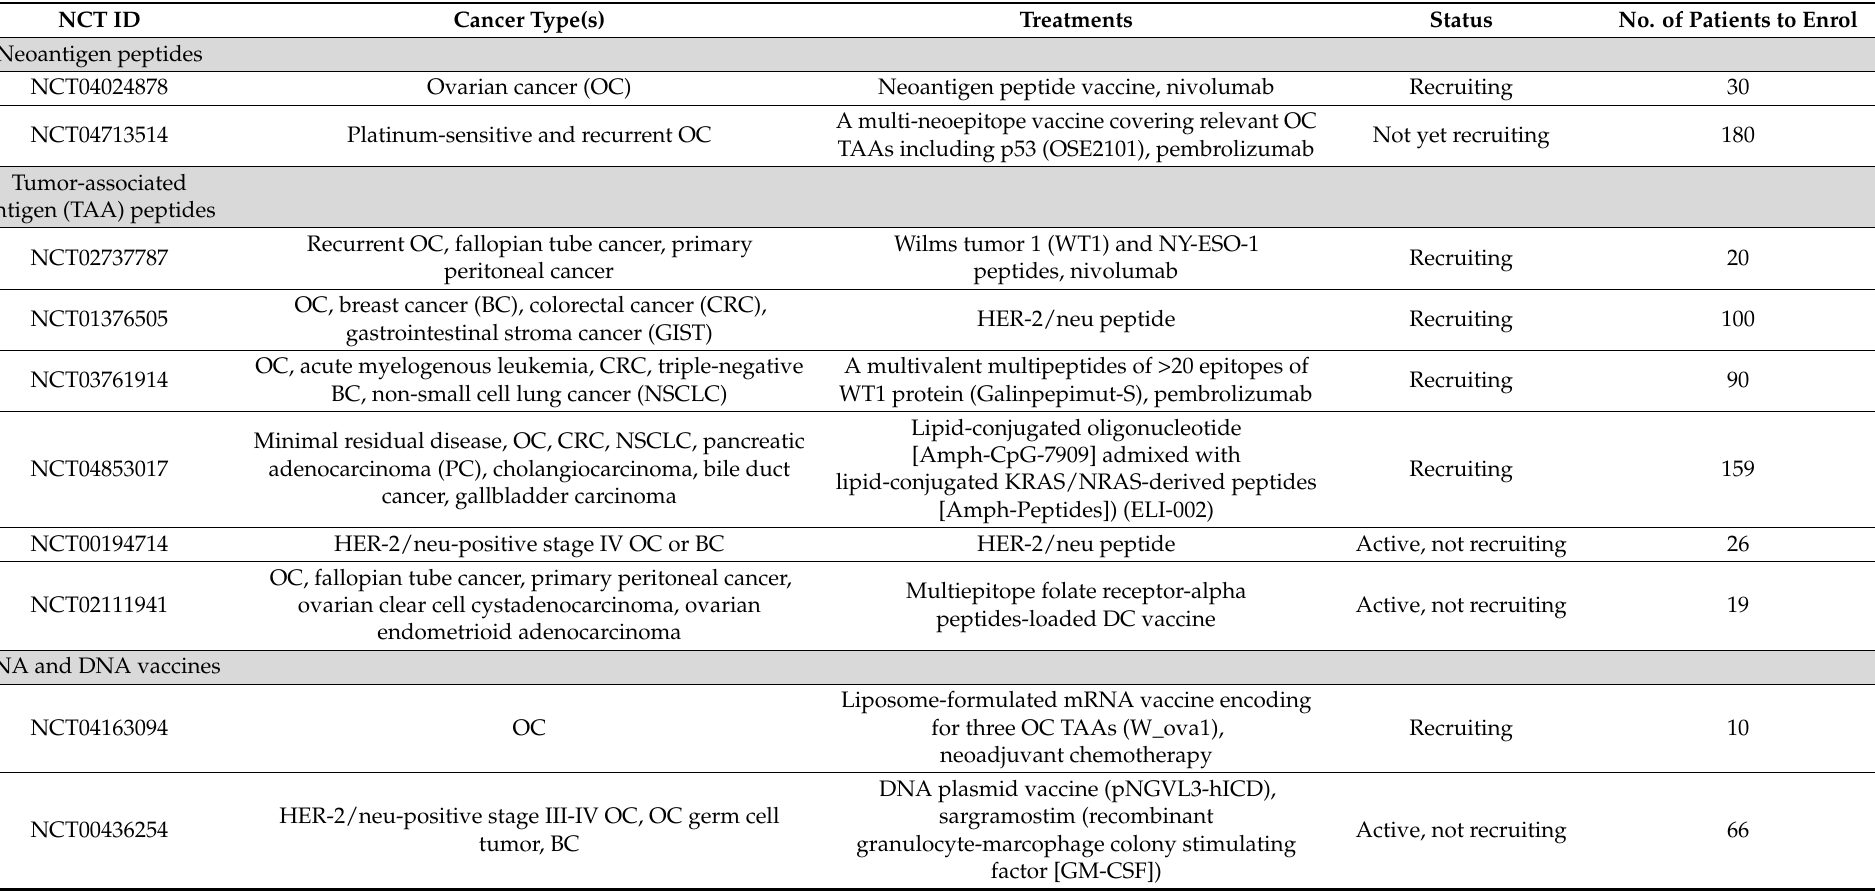
Table 2. Current OC clinical trials that are investigating cancer vaccine strategies, including two registered trials with unknown study status. Sources obtained from www.clinicaltrials.gov (accessed on 2 September